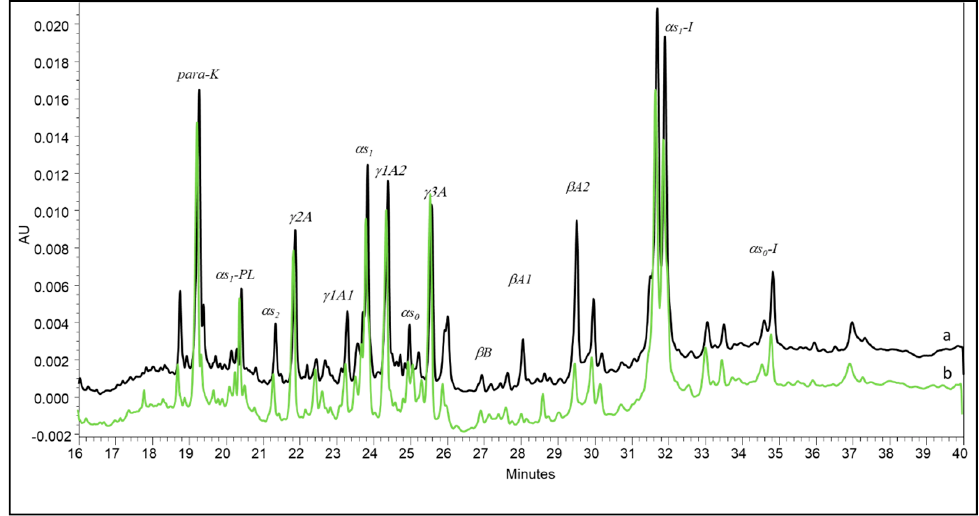
Figure 3. Capillary electrophoresis of Fontina PDO cheeses manufactured in a steel vat (a) and in a copper vat (b) respectively.